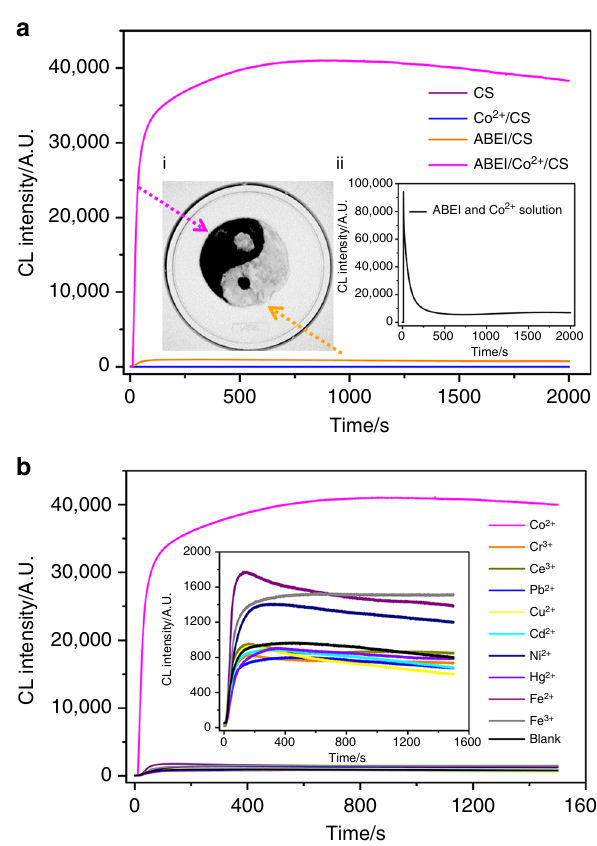
Fig. 3 CL performance. a CL kinetic curves for reaction of CS hydrogels, Co 2+ /CS hydrogels, ABEI/CS hydrogels, ABEI/Co 2+ /CS hydrogels with H 2 O 2 . Inset (i): gel CL imaging of ABEI/Co 2+ /CS hydrogel-H 2 O 2 (black) and ABEI/CS hydrogel-H 2 O 2 (white). Inset (ii): CL kinetic curves for reaction of Co 2+ -ABEI-H 2 O 2 system with a fi xed photomultiplier tube (PMT) voltage of − 450 V. b CL kinetic curves for reaction of ABEI/metal ion/CS hydrogels using different metal ions (Co 2+ , Cu 2+ , Pb 2+ , Ni 2+ , Hg 2+ , Cr 3+ , Ce 3+ , Cd 2+ , Fe 2+ , Fe 3+ and blank) with H 2 O 2 . Inset: magni fi cation of Cu 2+ , Pb 2+ , Ni 2+ , Hg 2+ , Cr 3+ , Ce 3+ , Cd 2+ , Fe 2+ , Fe 3+ and blank (without metal ion) in the ABEI/metal ion/CS hydrogels-H 2 O 2 . Reaction